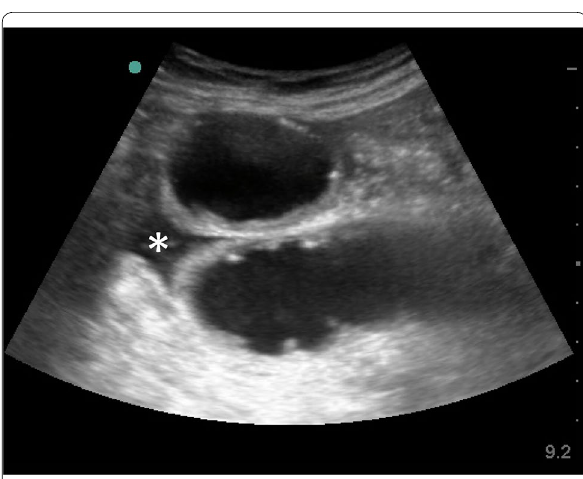
Fig. 5 CT abdomen with contrast showed dilated small bowel loops in the right side of the lower abdomen and pelvis with a short segment critical stenosis measuring about 2.3